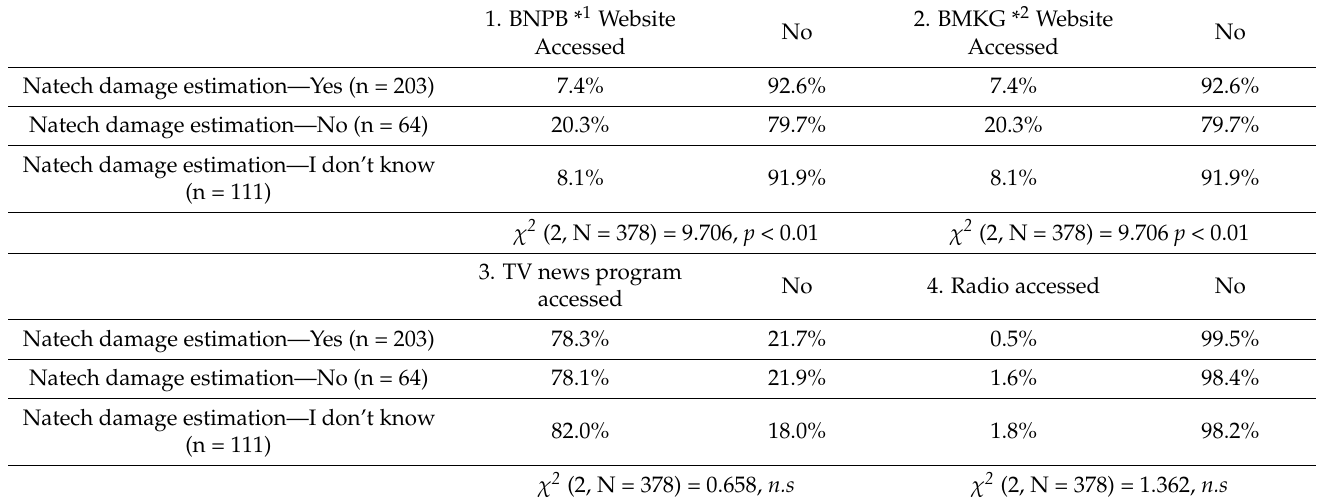
Table 6. Natech damage estimation and information access (N =